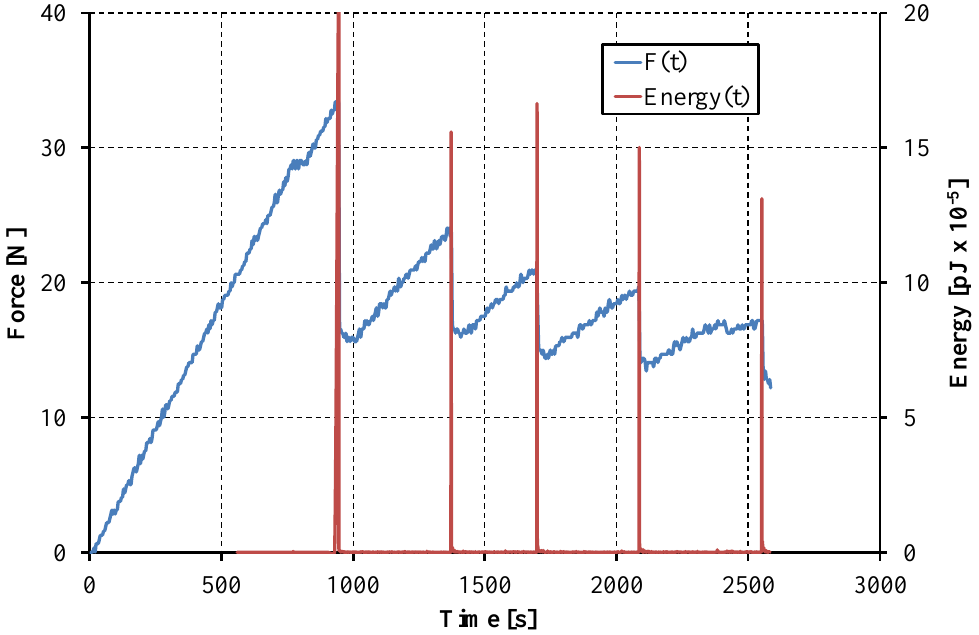
Figure 4. Example of detecting the peak load using the energy of AE.